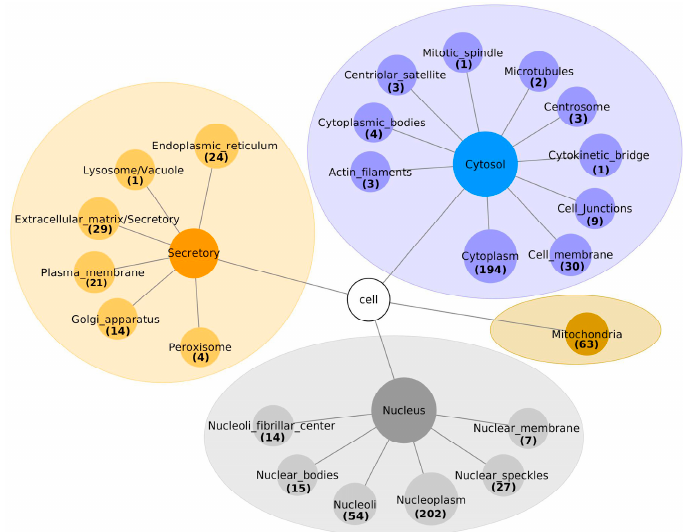
Figure 2. The sub-cellular localization of proteins interacting with SDC1, classified into cytosol, mitochondria, nucleus and extracellular matrices.